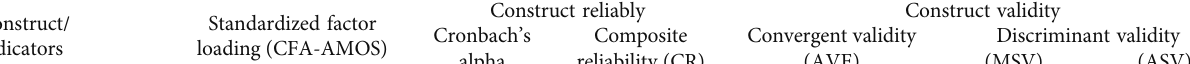
Table 2: Con fi rmatory factor